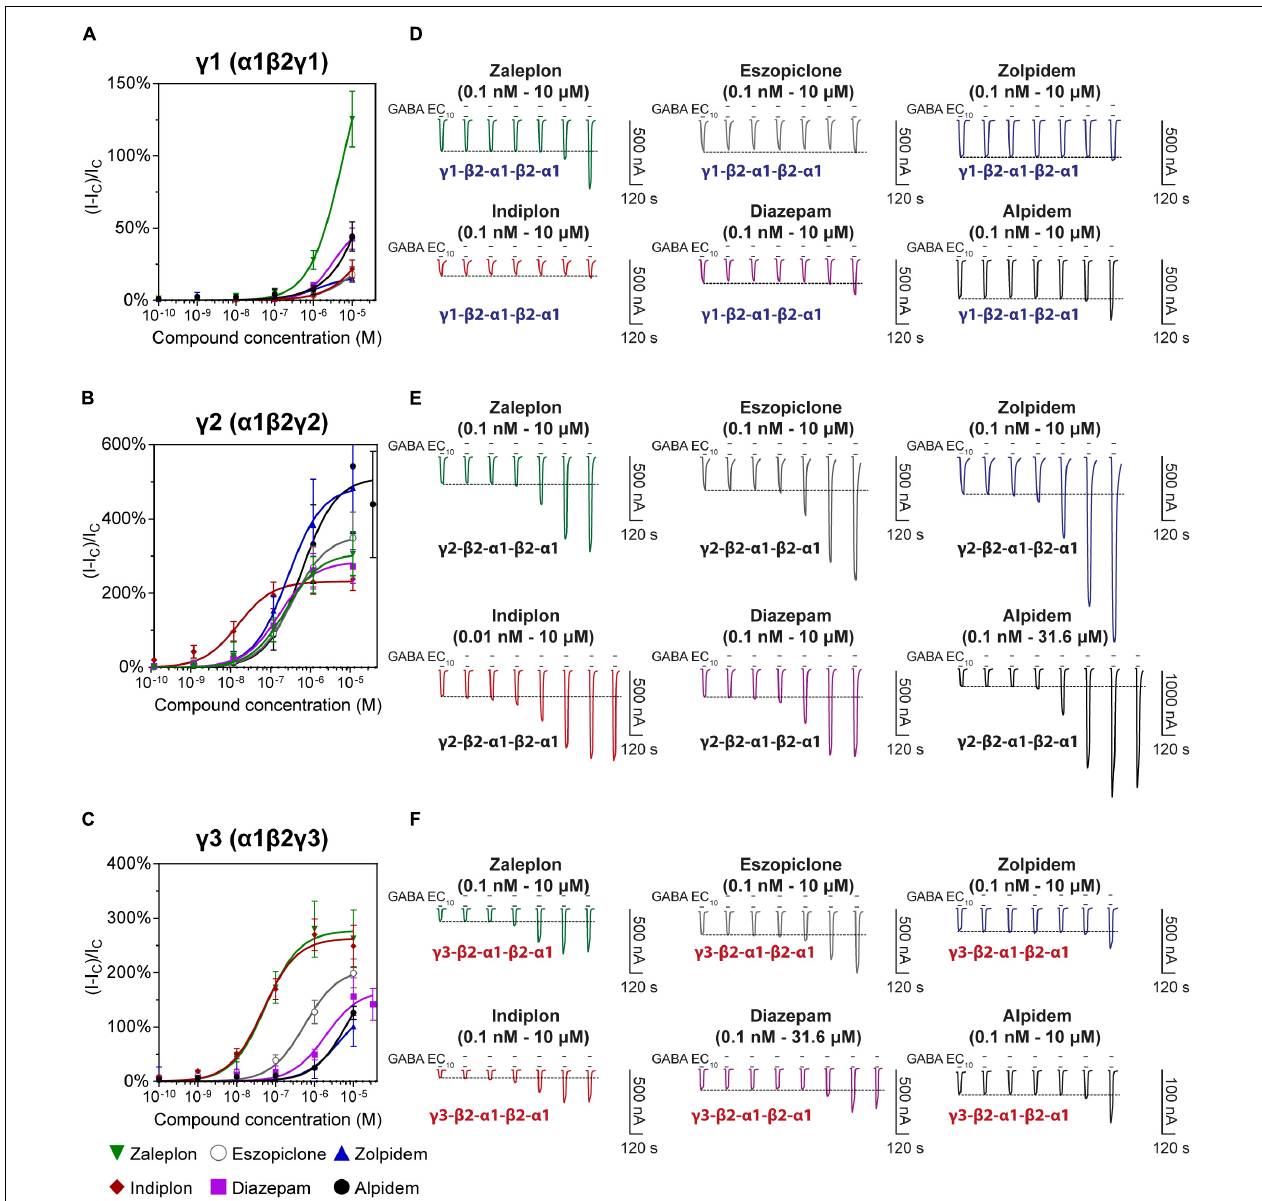
FIGURE 4 | Modulatory actions of zaleplon, indiplon, eszopiclone, diazepam, zolpidem, and alpidem, on GABA evoked Cl − currents measured in human (A) α 1 β 2 γ 1, (B) α 1 β 2 γ 2, and (C) α 1 β 2 γ 3 GABA A receptors expressed in Xenopus laevis oocytes measured via two-electrode voltage-clamp. The data are expressed as a percentage potentiation of GABA EC 10 and are means ± SD ( n = 4–8 from at least 2 separate Xenopus laevis donors). Data points were fitted to the Hill equation with bottom set to 0 and slope constrained to 1. (D–F) Representative traces illustrating modulator concentration-response experiments.